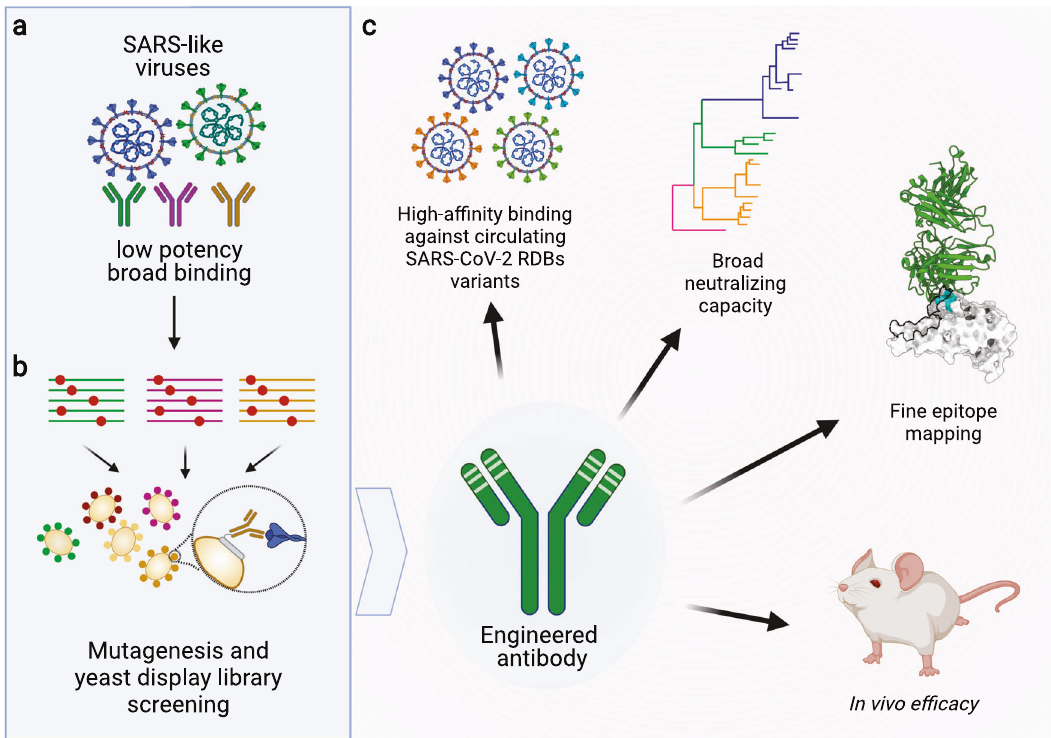
Fig. 1 a Isolated antibodies from a 2003 SARS survivor showed cross-neutralize activity for SARS-like viruses albeit with low potency. b Antibody engineering to increase binding af fi nity against SARS-CoV-2 S protein using deep mutagenesis and yeast library display. c Structural and molecular characterization of engineered antibodies displaying high neutralization breadth and potency against clade-1 sarbecoviruses. Figure created with